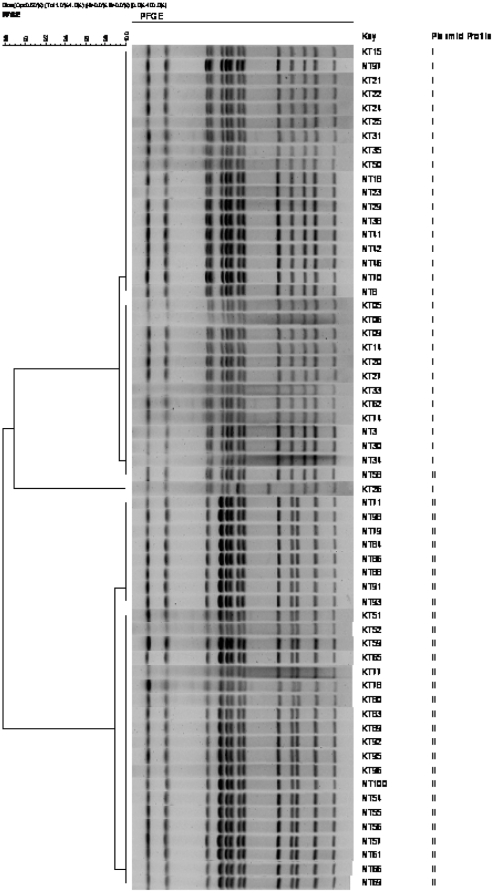
Dendrogram showing the cluster analysis on the basis of XbaI-PFGE of the 30 Salmonella Kentucky and 30 non-serotyped isolates obtained from commercial layer poultry farms in Bangladesh, 2009–2010.Dice coefficient was used to perform similarity analysis, and clustering was performed by using unweighted pair-group method with arithmetic means (UPGMA) with 1% band position tolerance and 0.5% optimization parameter. KT, S. Kentucky; NT, Non-serotyped.